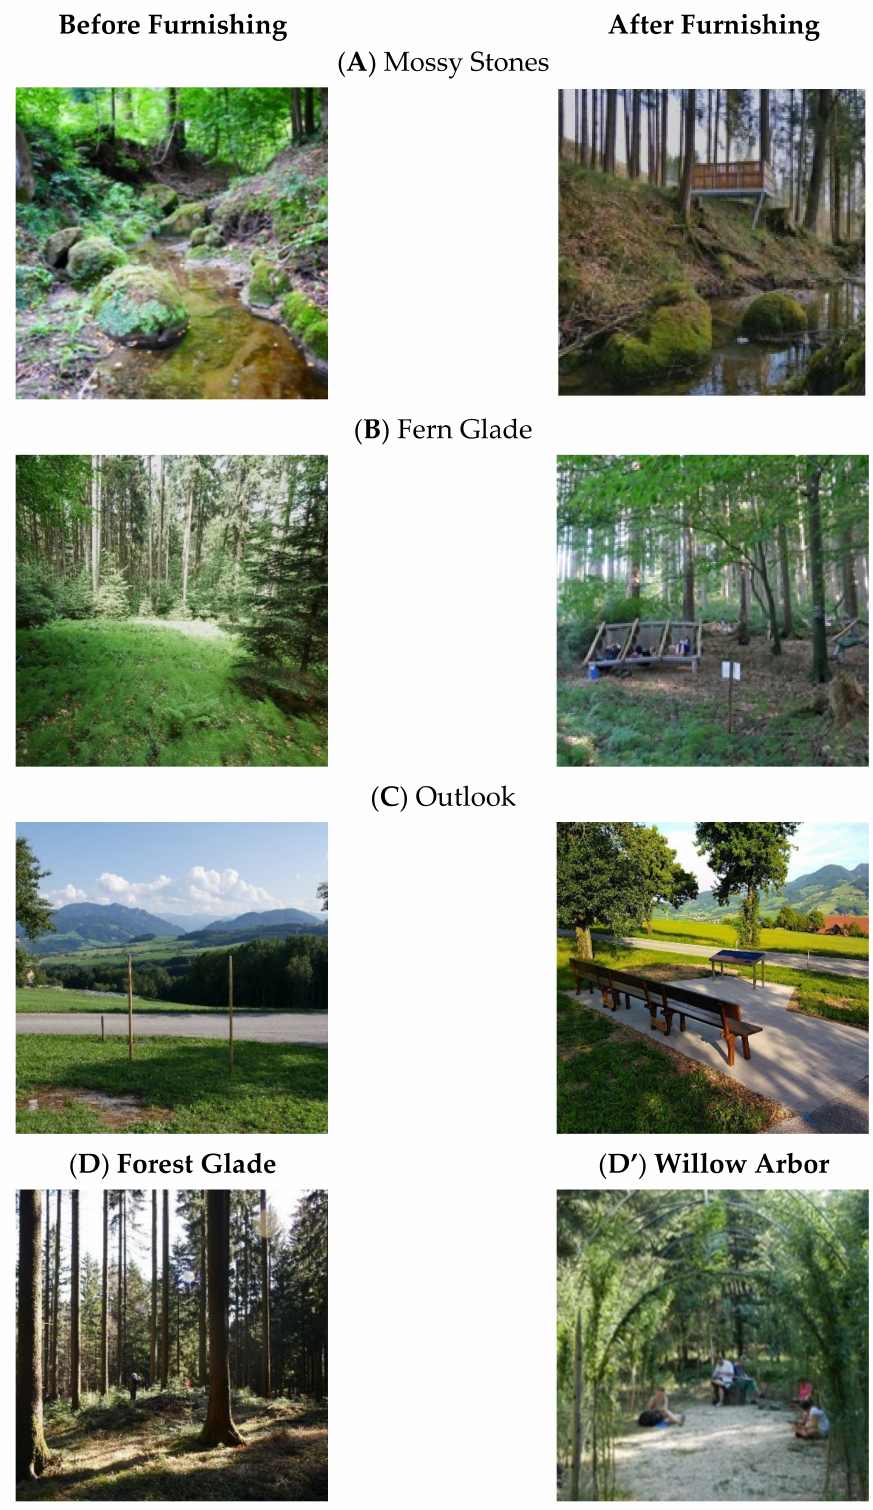
Figure 1. Four sites under study before and after